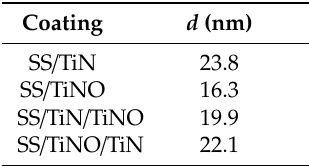
Table 2. Grain size ( d ) of the coatings.